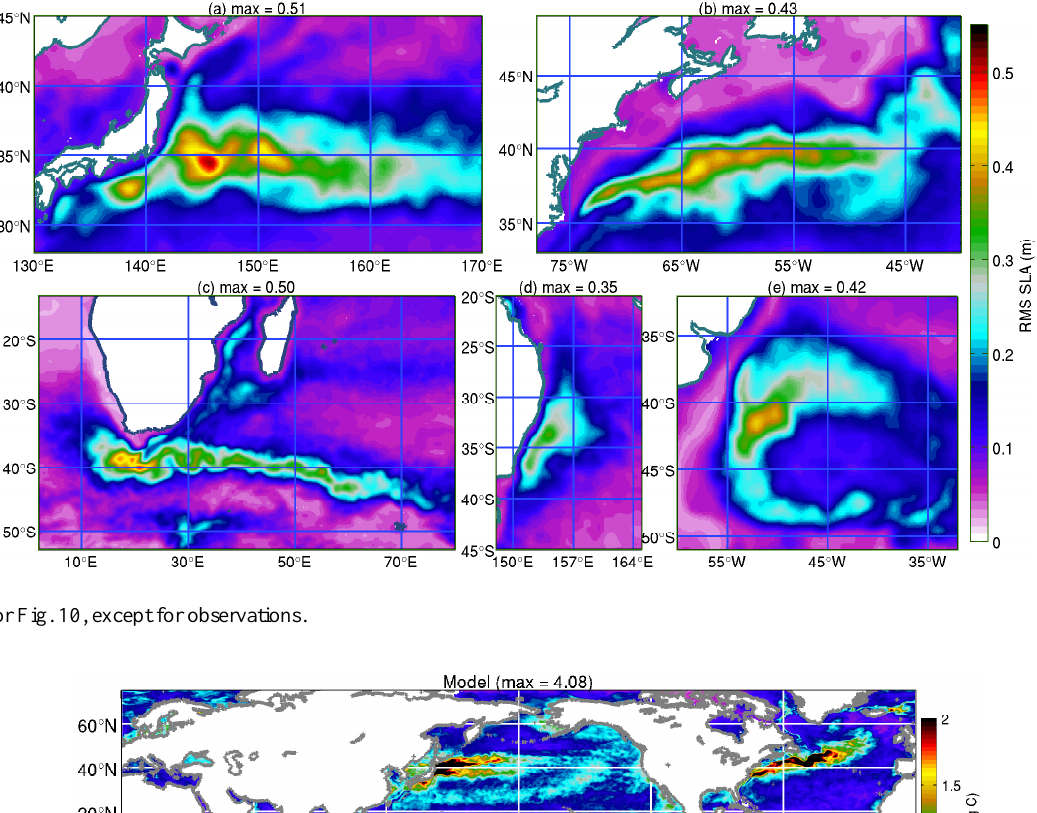
Fig. 11. As for Fig. 10, except for observations. Fig. 11. As for Figure 10, except for observations.